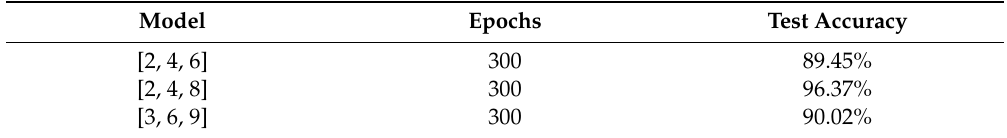
Table 4. Comparison of di ff erent atrous rates in the ASPP module.